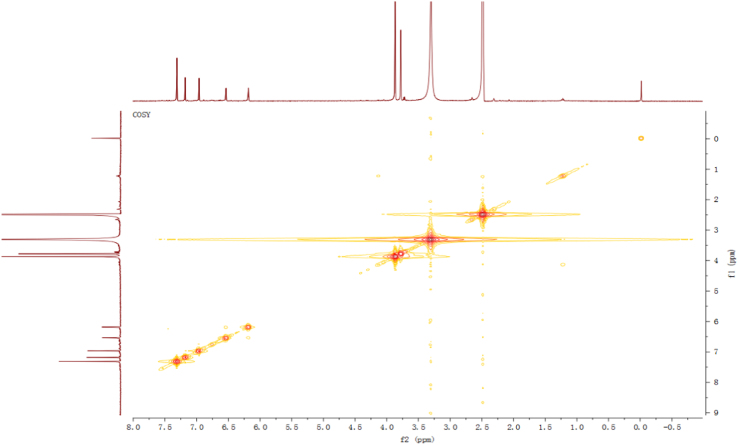
1H–1H COSY spectrum of compound 5.